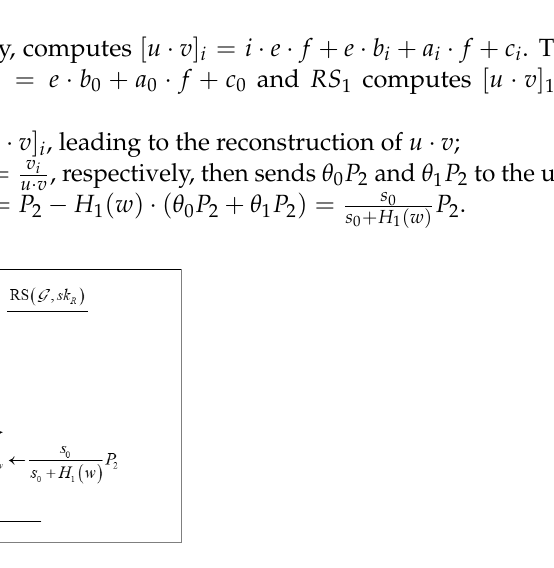
Figure 2. The RSD algorithm. Table 1. Symbol table in the